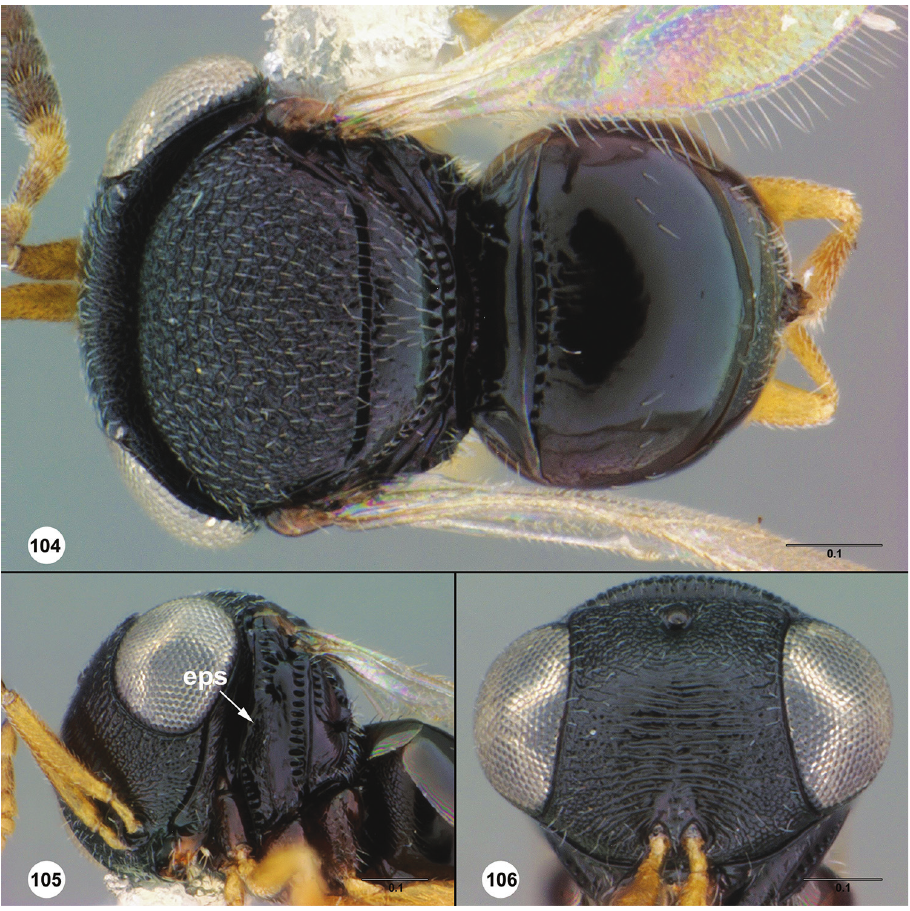
Figures 104–106. Trissolcus levicaudus 104 female holotype (OSUC 144511), head, mesosoma, metasoma, dorsal view 105 female holotype (OSUC 144511), head and mesosoma, ventrolateral view 106 female para- type (OSUC 144508), head, anterior view. Scale bars in millimeters. Subacropleural sulcus: present. Speculum: smooth. Mesopleural pit: simple. Meso- pleural carina: complete. Sculpture of femoral depression: smooth. Patch of striae at posteroventral end of femoral depression: absent. Setal patch at posteroventral end of femoral depression: absent. Microsculpture of anteroventral mesopleuron: present dorsally. Macrosculpture of anteroventral mesopleuron: absent. Postacetabular sulcus: formed by large cells. Setation of posteroventral metapleuron: present. Sculpture of dorsal metapleural area: absent. Posterodorsal metapleural sulcus: present as line of fo- veae. Paracoxal sulcus in ventral half of metapleuron: indistinguishable from sculpture to absent; absent. Anteroventral extension of metapleuron: not extending to base of mesocoxa. Metapleural epicoxal sulcus: present as coarse rugae. Mesoscutal humeral sulcus: indicated by a line of cells. Median mesoscutal carina: absent.